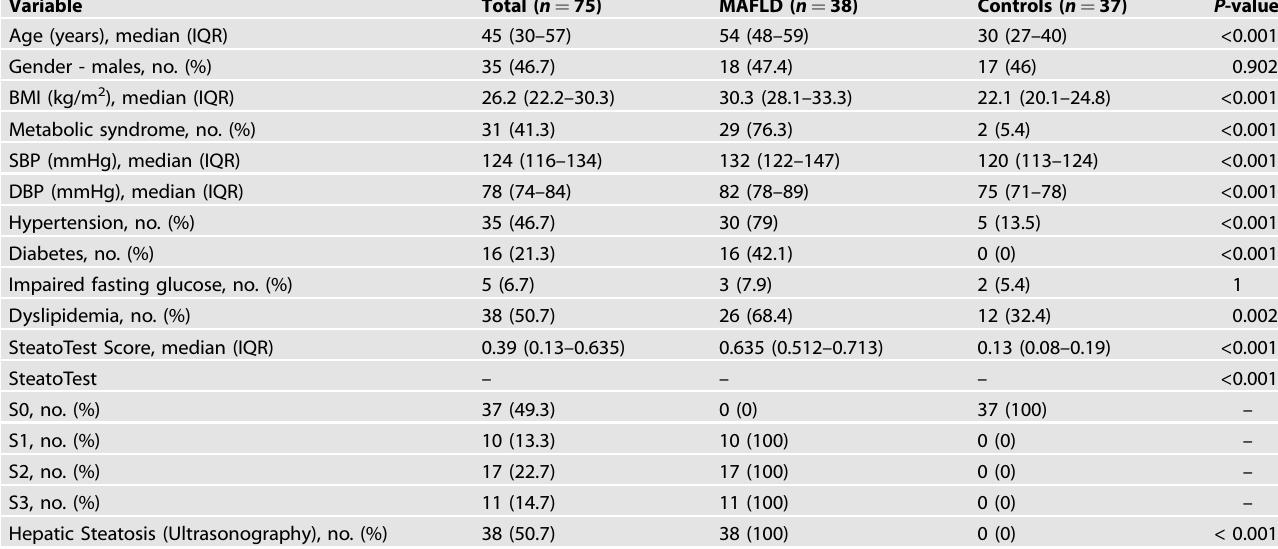
Table 1. General characteristics of included participants.